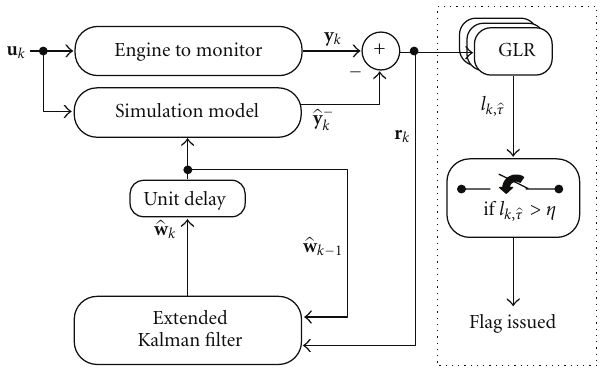
Figure 3: Integration of the GLR detector with the Kalman